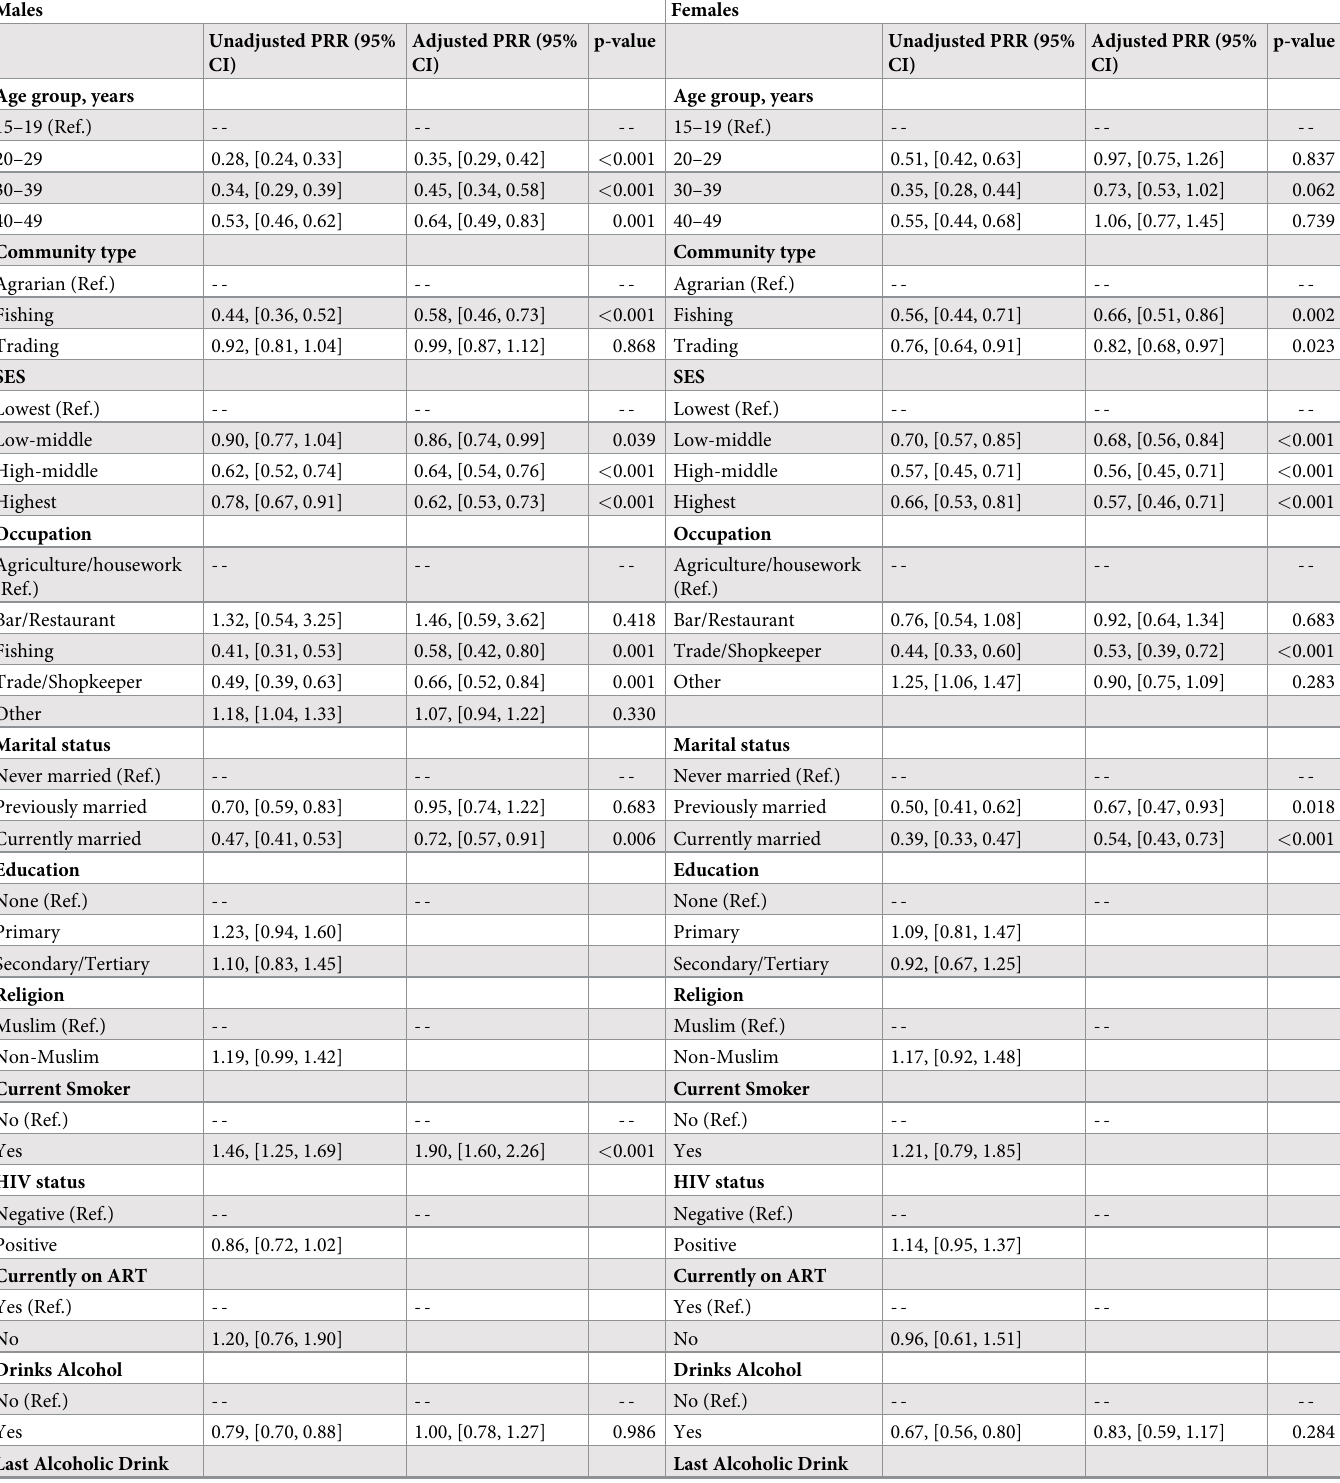
Table 7. Predictors of underweight from adjusted and unadjusted multivariable analysis models for male and female